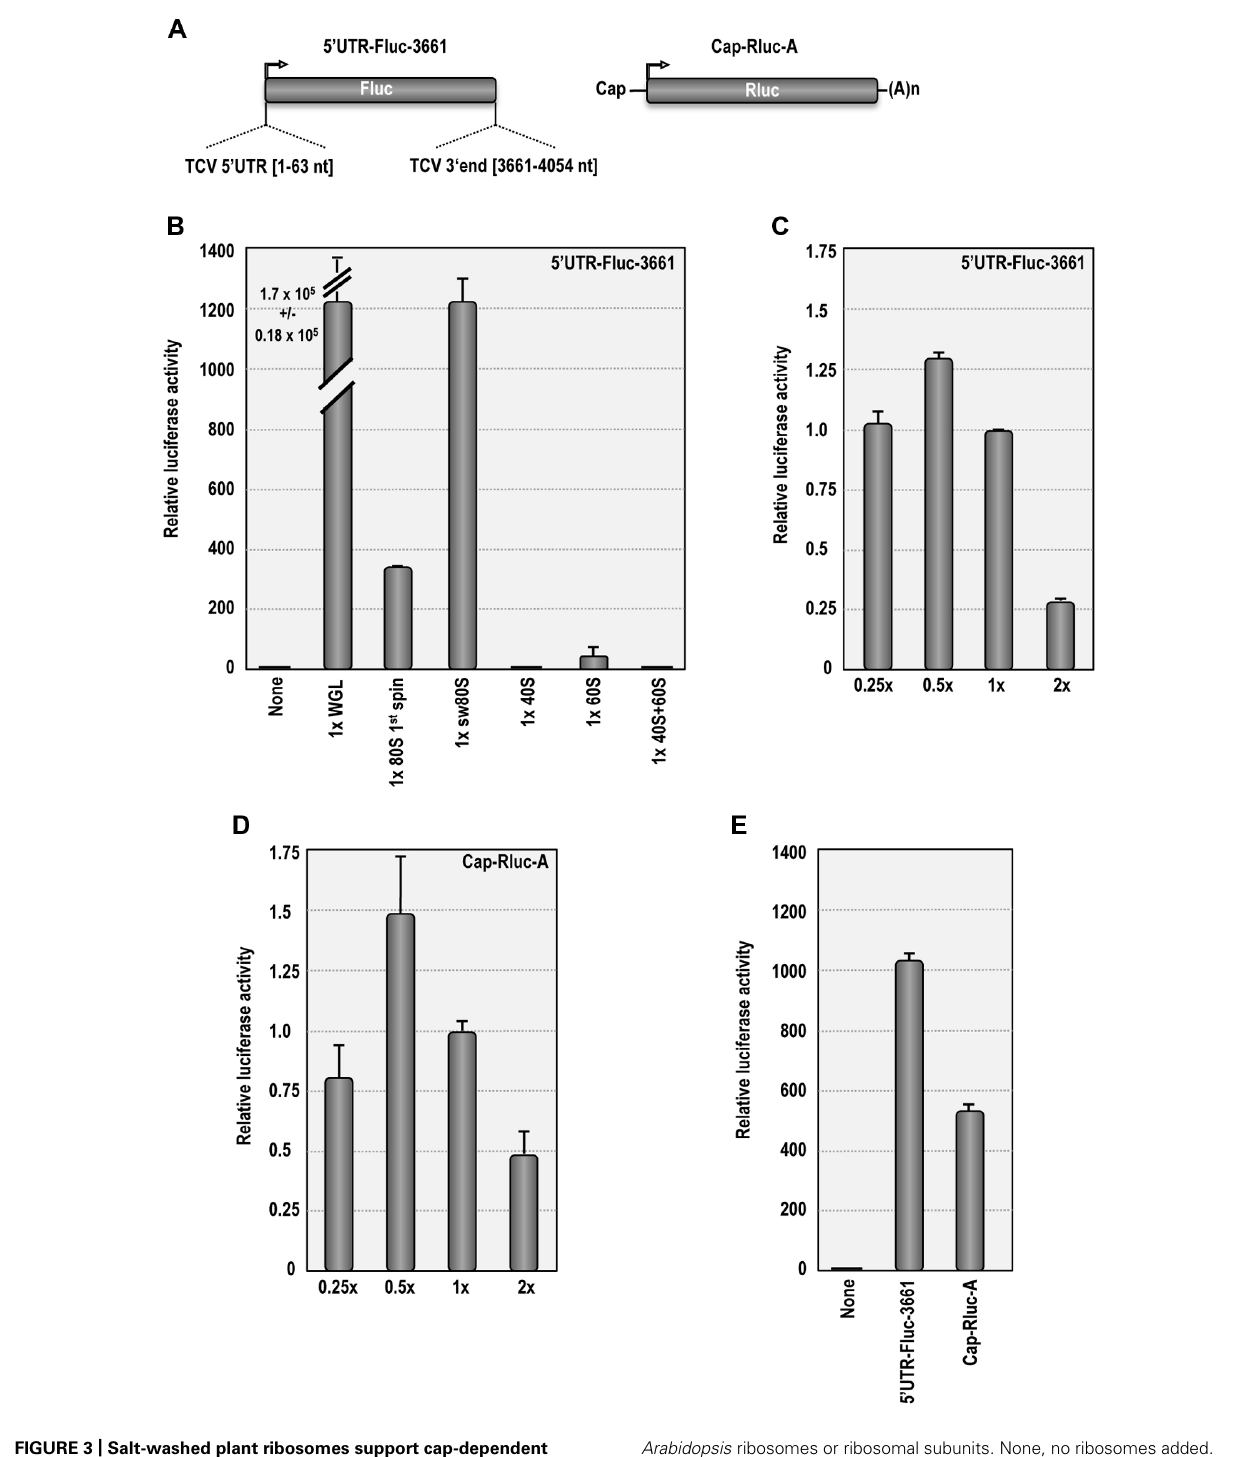
Arabidopsis ribosomes or ribosomal subunits. None, no ribosomes added. (C) In vitro translation of 3 (cid:2) UTR-Fluc-3661 using ribosome-depletedWGL supplemented with different concentrations of sw Arabidopsis ribosomes. (D) Translation of Cap-Rluc-A using different concentrations of sw Arabidopsis ribosomes. (E) Comparison of cap-dependent (Cap-Rluc-A) and cap-independent (5 (cid:2) UTR-Fluc-3661) translation using 0.5 × sw Arabidopsis